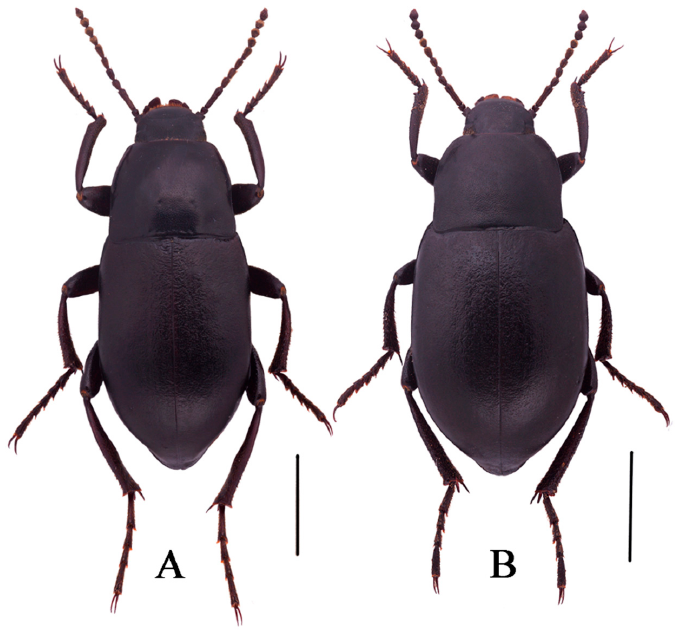
Figure 14. Habitus of N. acuminata sp. n. (( A ) male, holotype; ( B ) female, paratype). Scale bars: 5.0 mm.